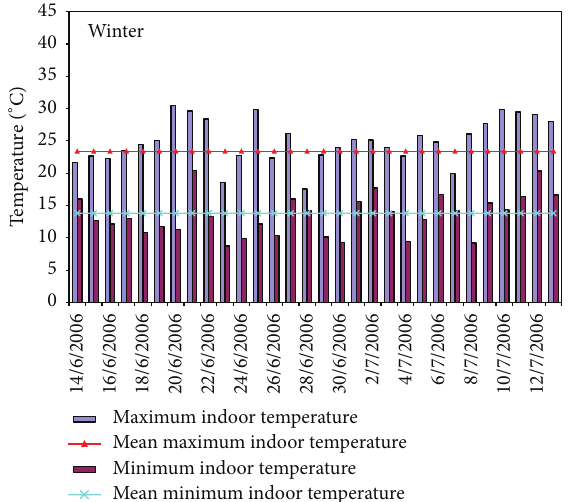
Figure 6: Daily maximum and minimum temperatures indoors during the winter period.